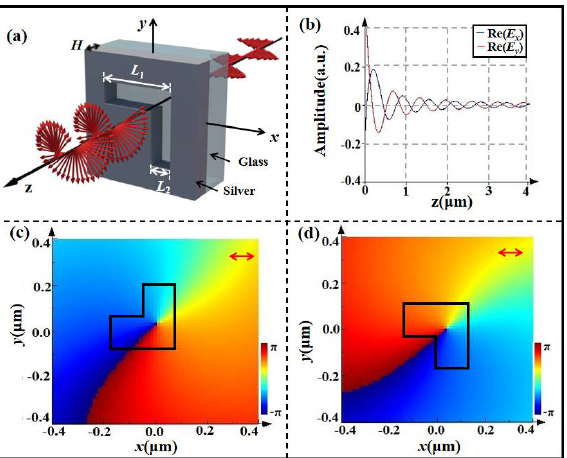
Figure 1. ( a ) Schematic diagram for polarization transformation of nanohole, ( b ) the transmission amplitude and ( c , d ) phase distributions of nanohole with its orientation directions along diagonal and anti-diagonal